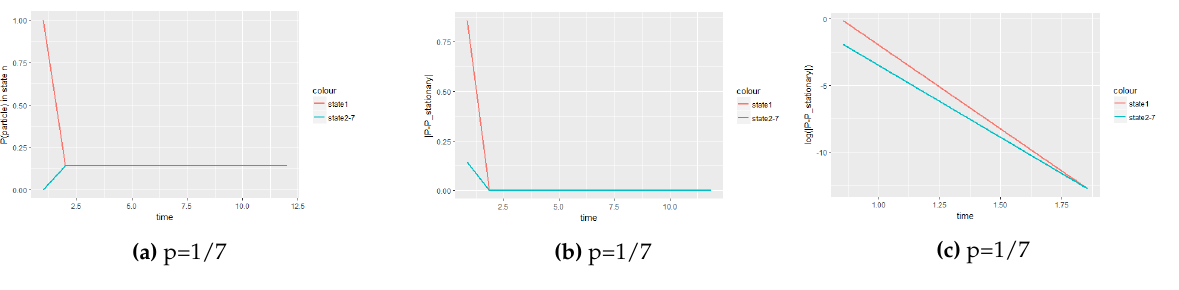
Figure 7. A panel of graphs to show how fast the equilibrium is attained in log scale under hexagonal tiling when the particle is initially at the central with probability vector v = ( 1,0,0,0,0,0,0 )